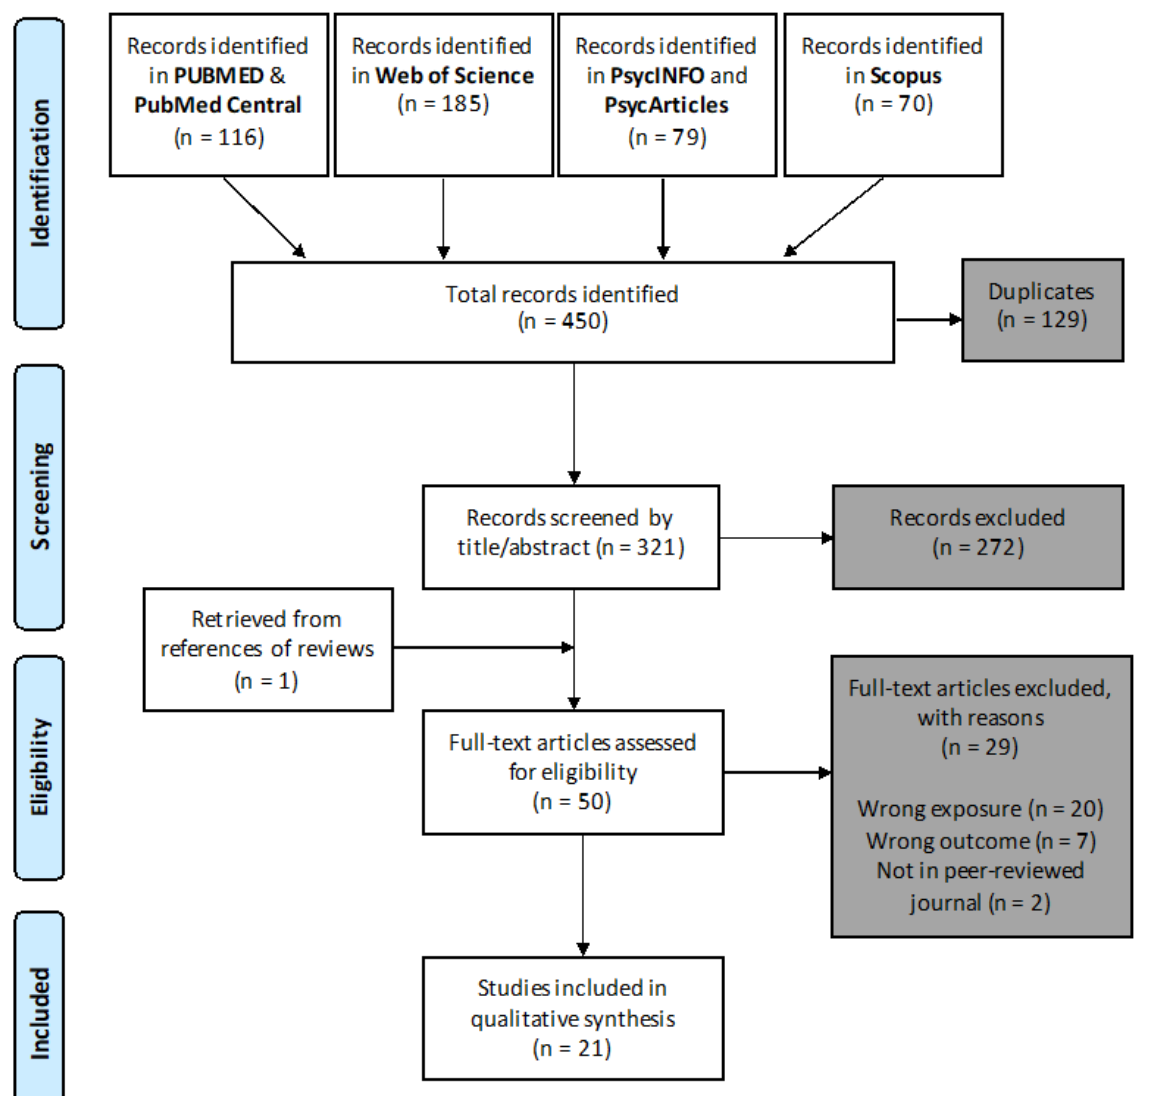
Figure 1. Preferred reporting items for systematic reviews and meta-analyses (PRISMA) flow diagram depicting the number of reports screened and included in this systematic